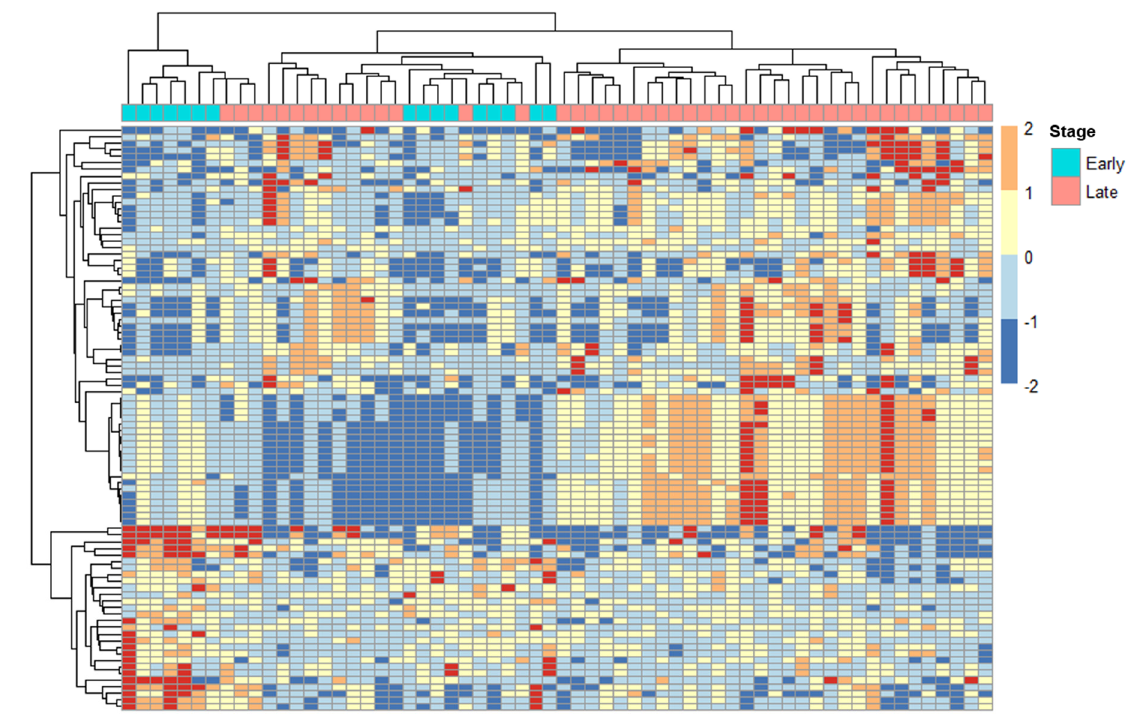
Figure 2. Transcriptome analysis of ERVs in early and locally advanced-stage/late cervical cancer patients. Heatmap generated using the normalized expression values for ERVs from the Human Endogenous Retrovirus database (HERVd). The plot above depicts the most significant ERVs ( p adj < 0.1) that were differentially expressed among tumor samples of different stages; late/locally advanced patients (n = 46), early patients (n = 16), 1 patient was excluded from this comparison (a complete list of differentially expressed ERVs is displayed in Supplementary Table S3). ERV expression levels is indicated by color intensity ( − 2.0 to 2.0) on a log scale; red indicates ERVs with higher expression, and blue indicates ERVs with lower expression. Early = FIGO early stage IA1–1B2; Late = FIGO locally advanced stage IB3-IVA